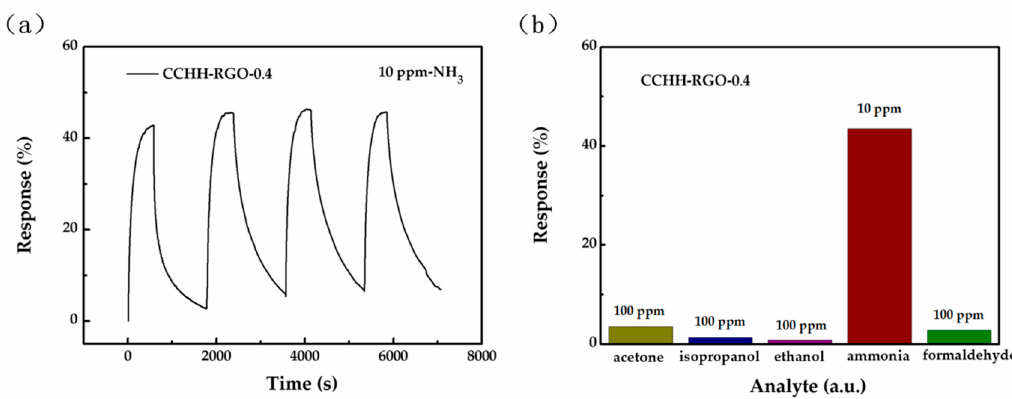
Sensors 2019 , x , x FOR PEER REVIEW 8 of 11 Figure 6. ( a ) Gas sensing response curve of four sensors to 10 ppm ammonia; ( b ) Gas sensing response, response time and recovery time of four sensors for 10 ppm ammonia. The exposure of the CCHH-RGO-0.4 to four continuous cycles of 10 ppm ammonia was shown in Figure 7a. The sensor showed approximately the same response value and the response/recovery time, revealing its excellent repeatability under room temperature. In order to test the selectivity of